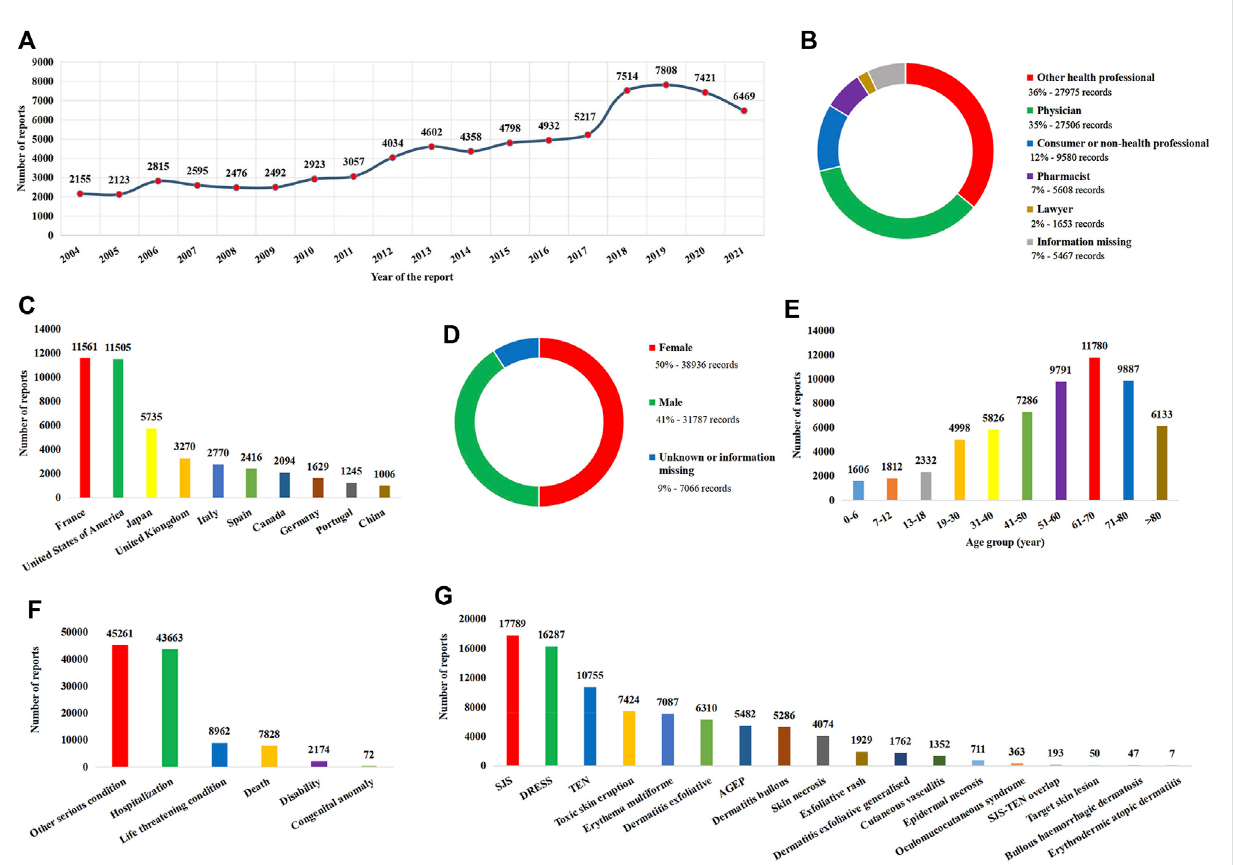
FIGURE 1 Basic information and patient characteristics according to the report. (A) Distribution of the reporting year. (B) Distribution of the reporter. (C) Top 10countrieswiththemostsourcesofreports. (D) Distributionofpatientgender. (E) Distributionofpatientage. (F) Distributionofthepatientoutcome. (G) Distribution of adverse reactions of preferred terms. AGEP, acute generalized exanthematous pustulosis; DRESS, drug reaction with eosinophilia and systemic symptoms; SJS, Stevens – Johnson syndrome; TEN, toxic epidermal